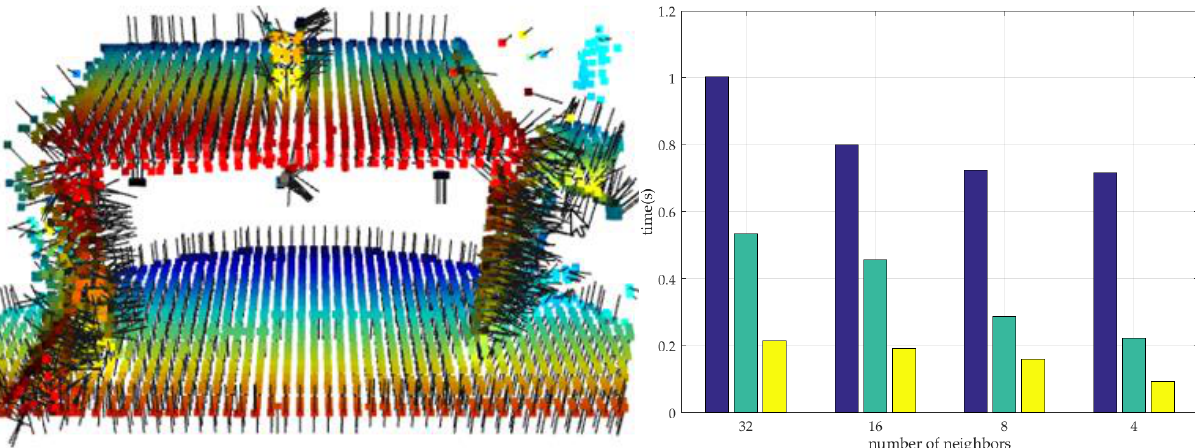
Figure 7. Visualization of Point Cloud with normal and time used by three structures computing normals. The left is the visualization of Point Cloud with normals, and the right is the time used by different structures computing normals. Blue bars represent octree, light green bars represent 3D R*-tree, and yellow bars represent the hybrid method proposed in this